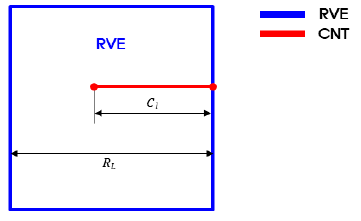
Figure 6. Simplified RVE model.